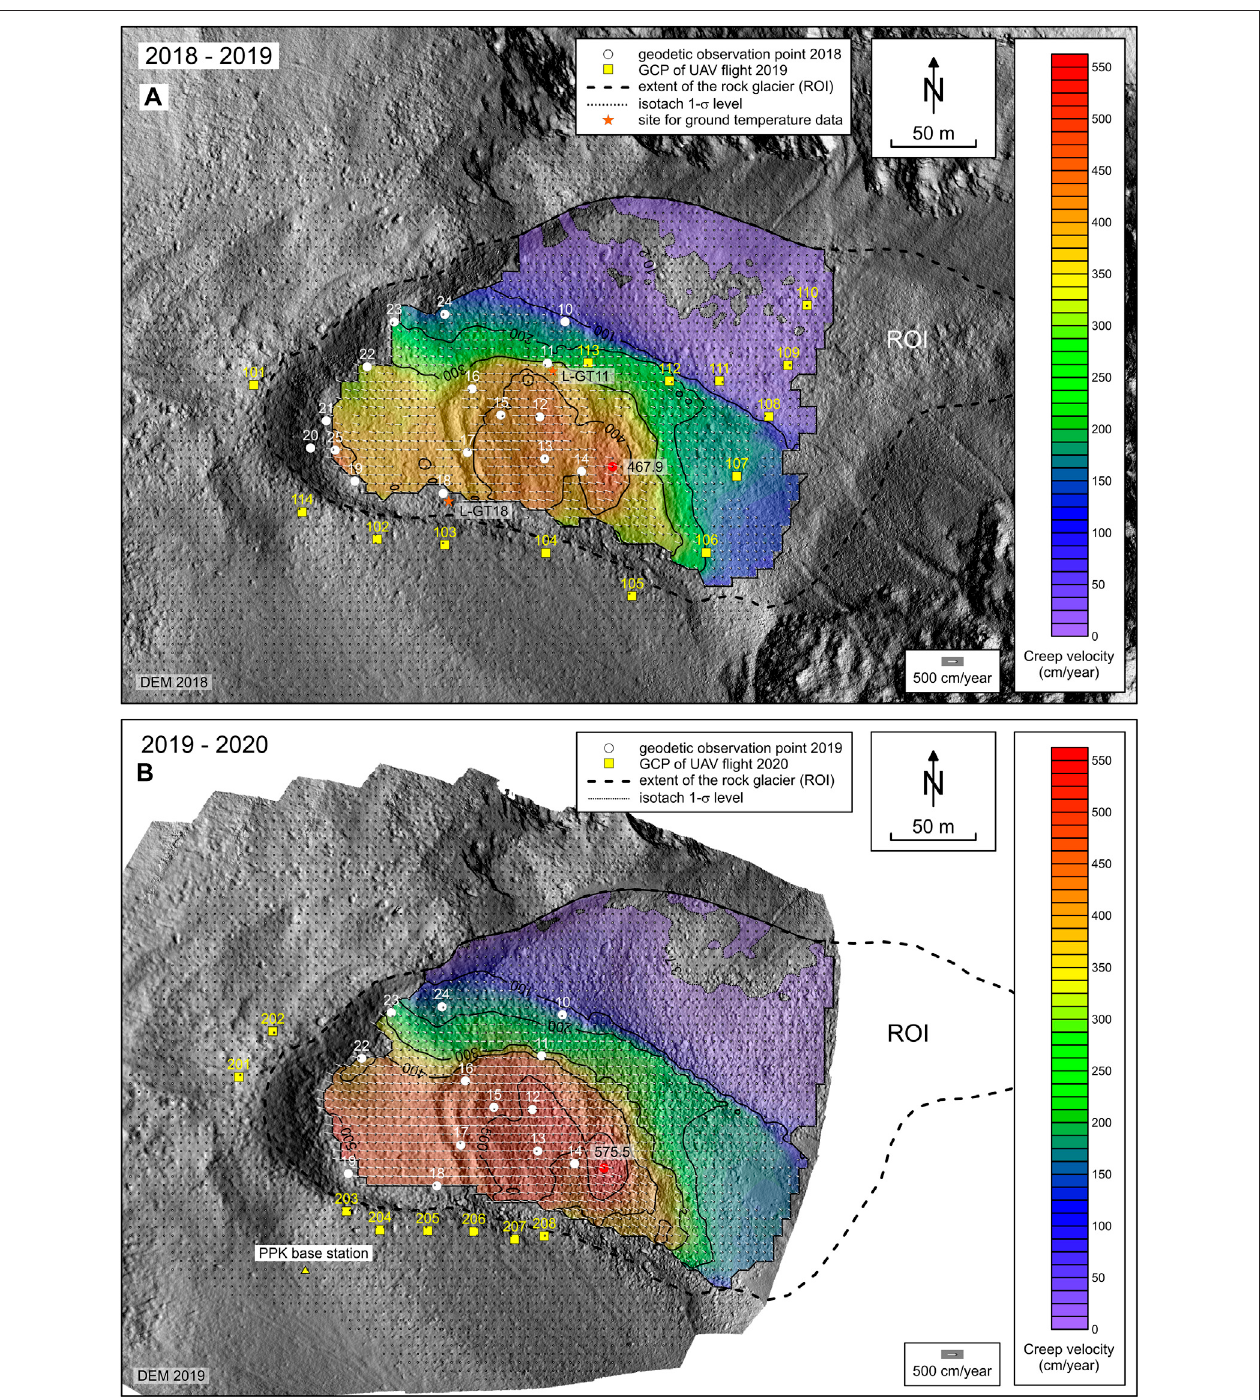
FIGURE 3 | Thematic maps showing the kinematics of the Leibnitzkopf rock glacier for the time periods 2018 – 2019 (A) and 2019 – 2020 (B) . The position of the maximum surface creep velocities during both years (467.9 and 575.5 cm/year) is indicated by a red dot.